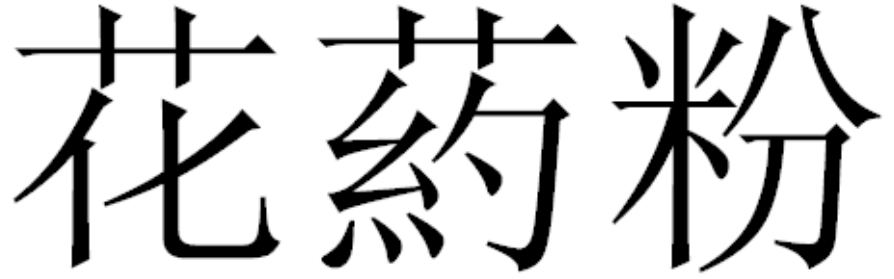
Figure 2. Three examples of simplified Chinese characters used as